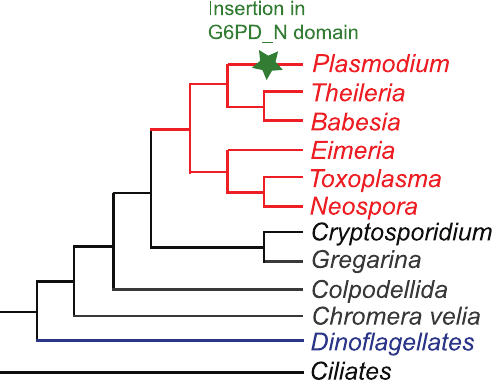
Figure 3. Phylogenetic tree of alveolates. Adapted from [36–38]. The taxa in red contain a fused version of G6PD; taxa in blue contain a non-fused gene. The taxa in black lack an ortholog of G6PD, while those in gray have no fully sequenced genome and have no G6PD sequence available for analysis. The green star in the Plasmodium branch of the tree represents the insertion observed in all Plasmodium species.